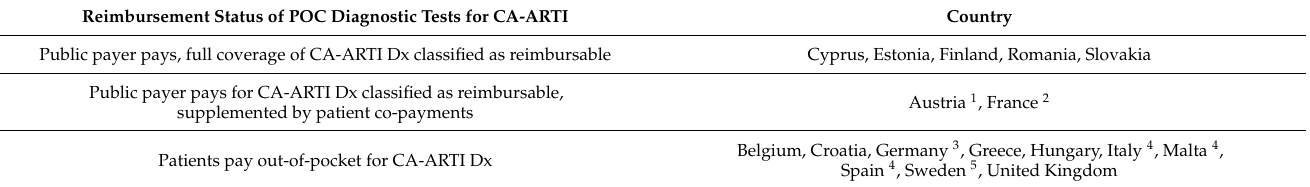
Table 2. Funding sources for CA-ARTI